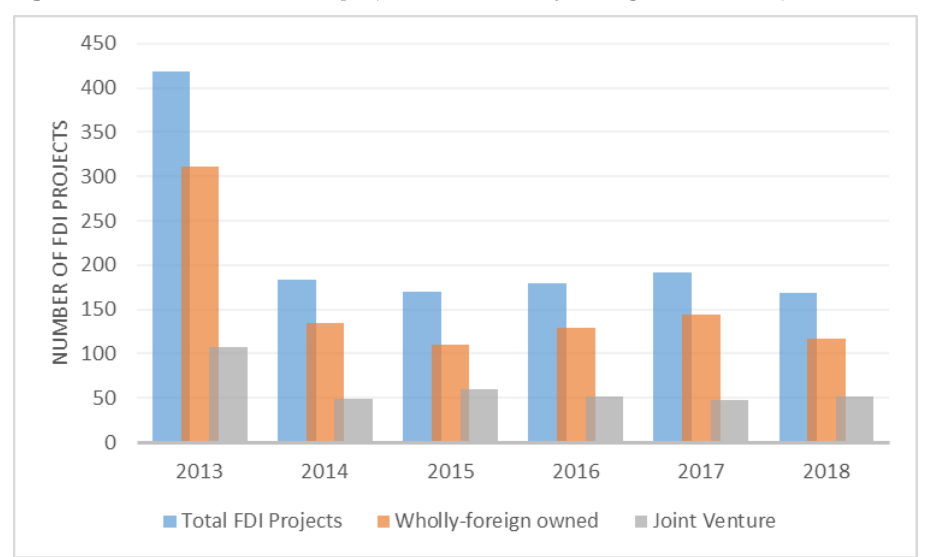
Figure 2 : Total Number of FDI projects verse wholly-foreign owned and joint venture